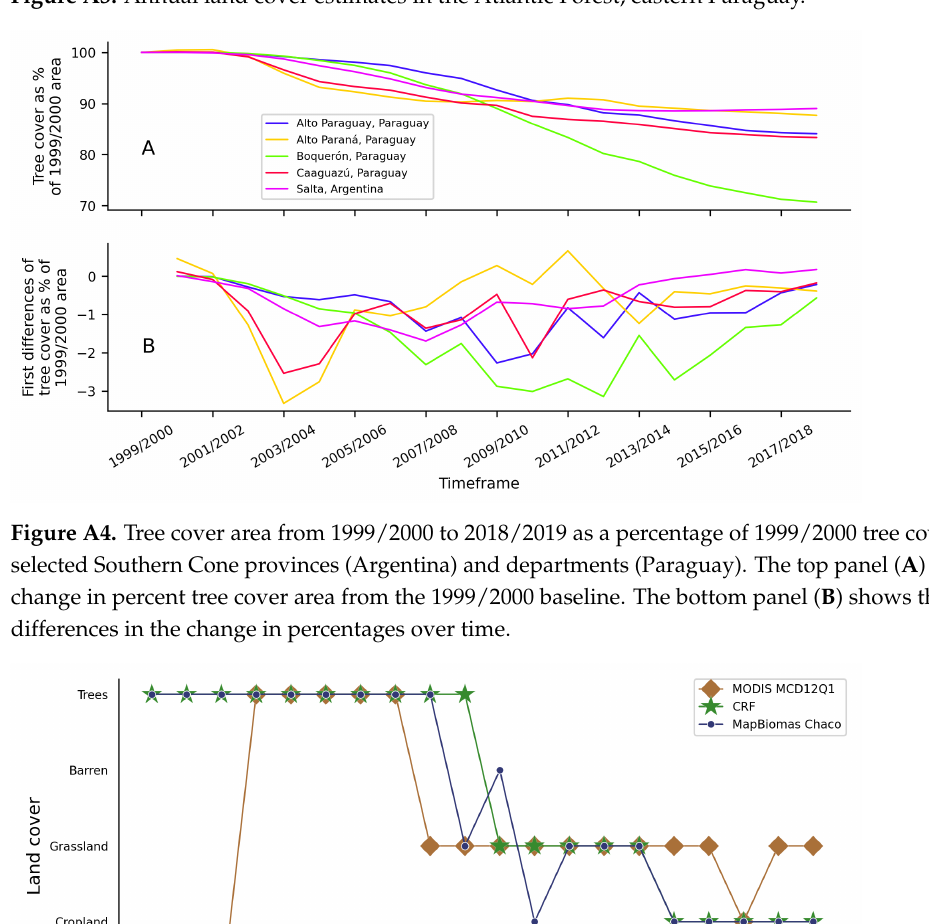
Figure A3. Annual land cover estimates in the Atlantic Forest, eastern Paraguay.